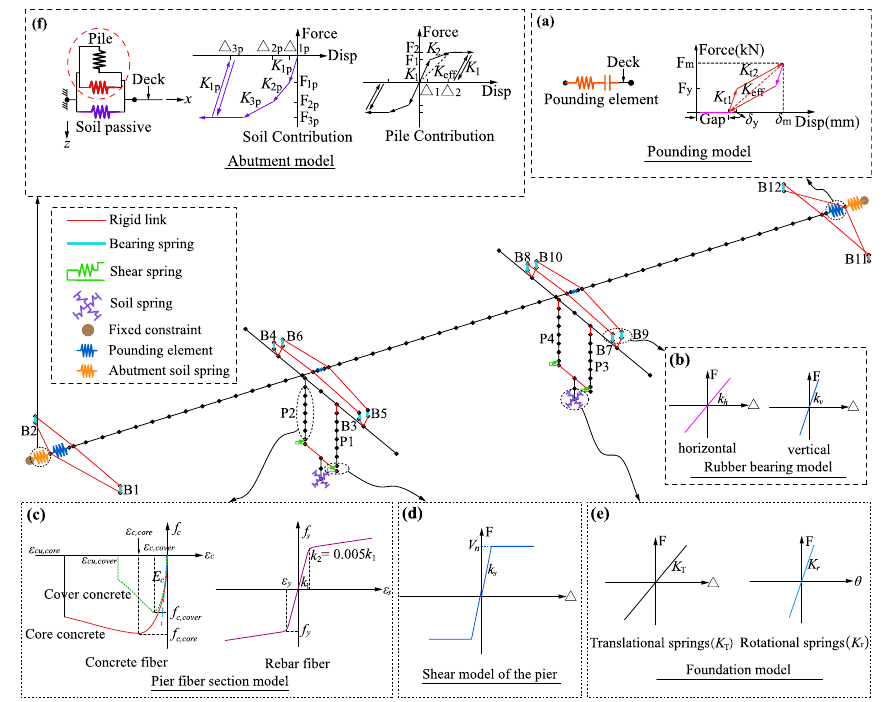
Fig. 2 Numerical modelling details of the case-study bridge: a pounding effect, b rubber bearing, c pier fiber section, d horizontal shear model of the pier, e SSI effects for the pier bents and f SSI effects for the